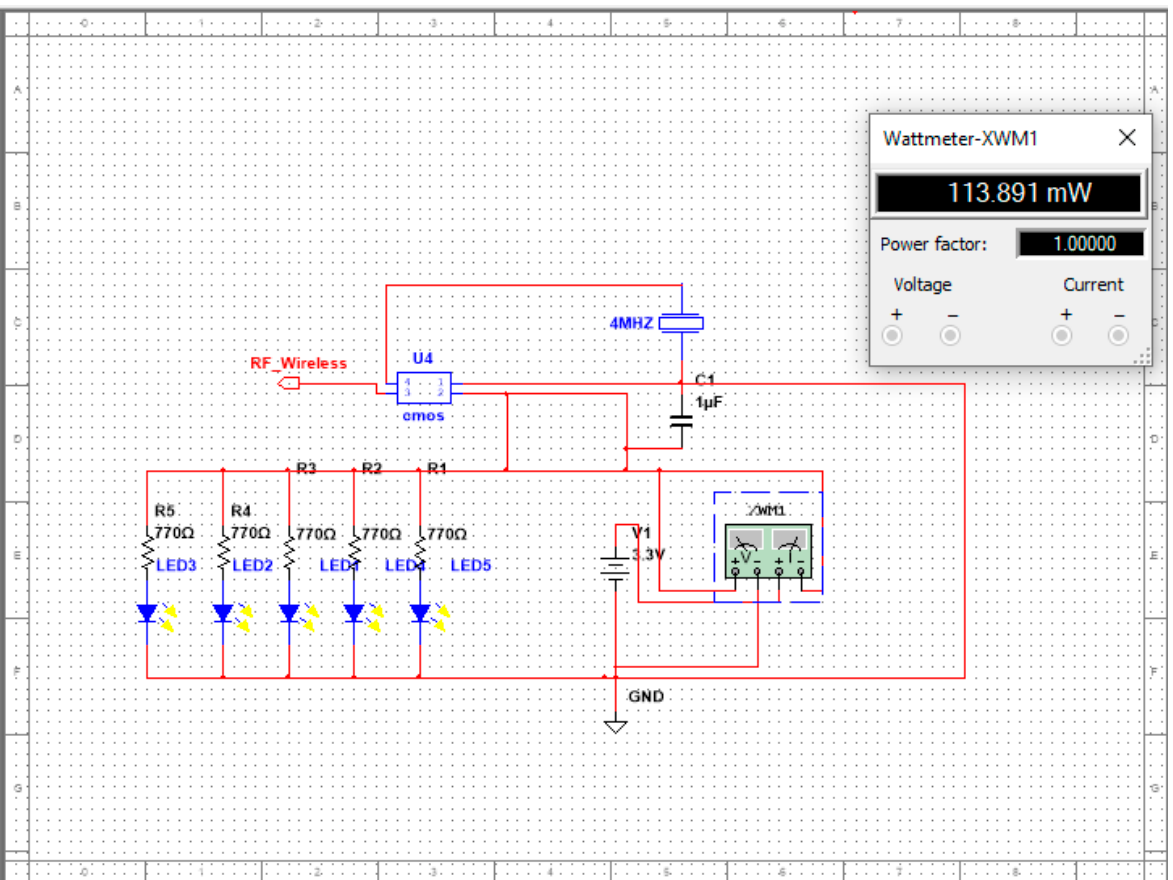
Figure 4. Circuit of 5-LED capsule.